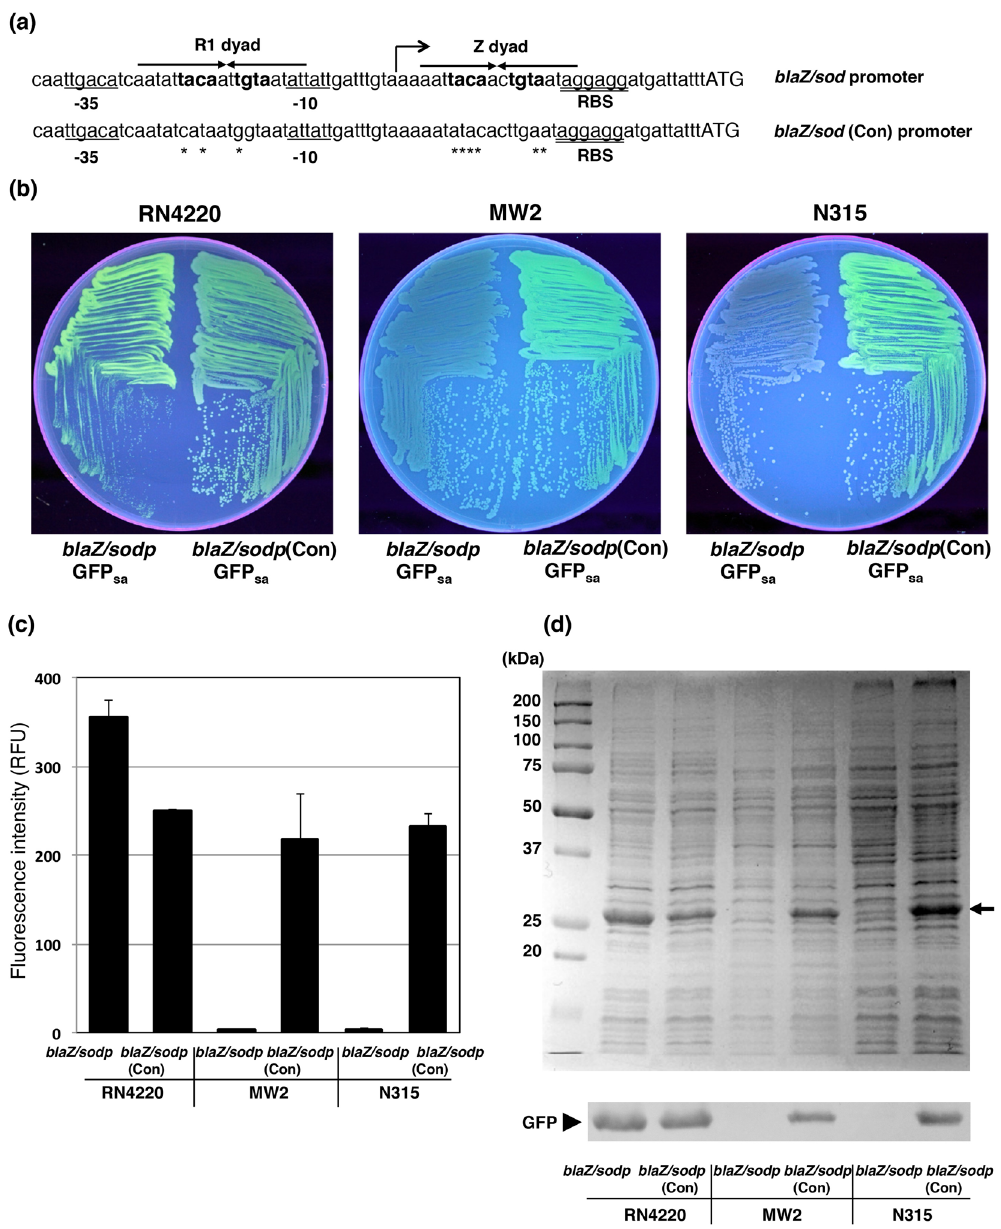
Figure 2. Site-directed mutagenesis into the BlaI/MecI binding sequence. ( a ) Sequence alignment of the blaZ / sodp and its constitutively induced blaZ / sodp (Con) promoter region. Asterisks indicate the sequence exchanged by site-directed mutagenesis. Bold face indicates the BlaI/MecI binding motif (TACA/TGTA) within the larger palindromes, the R1 dyad and Z dyad are indicated by arrows. Up arrows with the tip to right indicates the transcription initiation site. Underlined sequences indicate − 35 and − 10 elements. Double underline indicates the RBS sequence. Initiation codons are shown in uppercase. ( b ) The fluorescing colonies were photographed under UV excitation. S . aureus RN4220, MW2 and N315 containing either pFK52, or pFK54 were grown on TSB agar plate containing chloramphenicol. ( c ) The comparison of fluorescence intensity among S . aureus strain RN4220, MW2, and N315 containing either pFK52, or pFK54. The fluorescent intensities at 513 nm were measured with a microplate reader, λ ex = 490 nm. The data represent mean values ± standard deviation. ( d ) The comparison of GFP sa expression efficiency among S . aureus strain RN4220, MW2, and N315 containing either pFK52, or pFK54. SDS-PAGE and Western blot analysis show the relative quantities of GFP sa in the whole cell lysates. The arrow indicates the position of GFP sa in gel. The Western blot gel was cropped and the full-length image is included in Supplemental Fig.